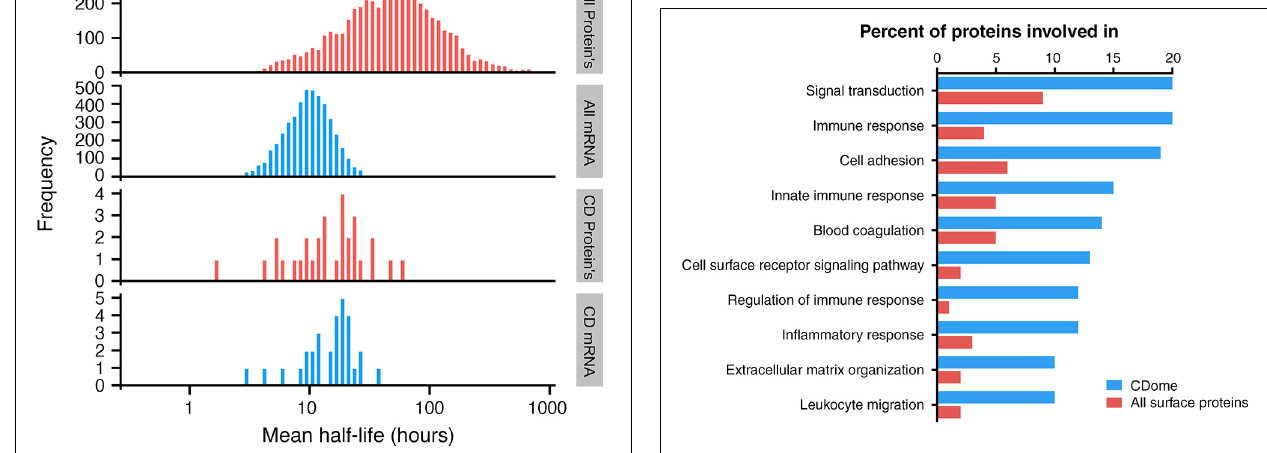
FIGURE 2 | Histogram of protein and mRNA half-lives in mammalian cells, based on Schwanhäusser et al. (2011). A subset of CD molecules for which data was available show faster turnover of membrane proteins (bottom 2 panels), when compared to all analyzed proteins (top 2 panels).